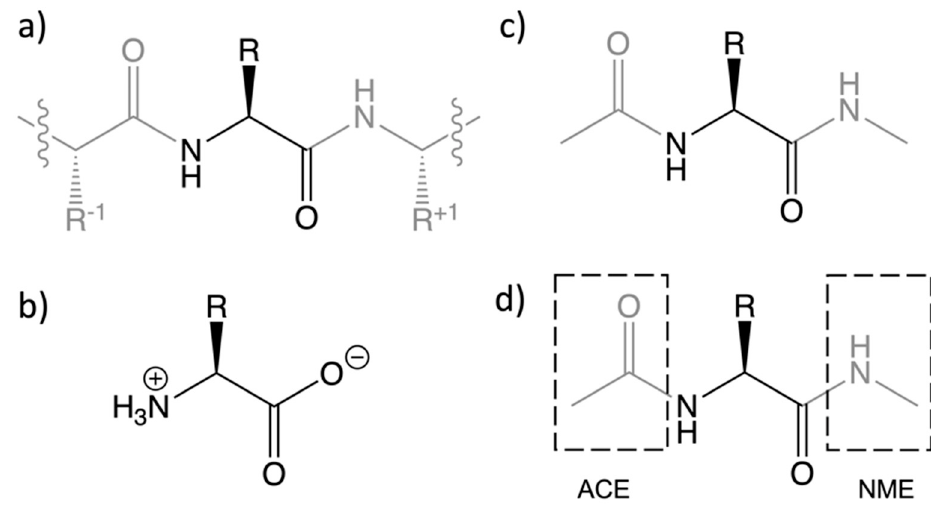
Scheme 1. ( a ) Amino acid (in black) inserted in a peptide/protein sequence. ( b ) Amino acid in zwit- terionic form. c , d ) Amino acid capped with ACE/NME.